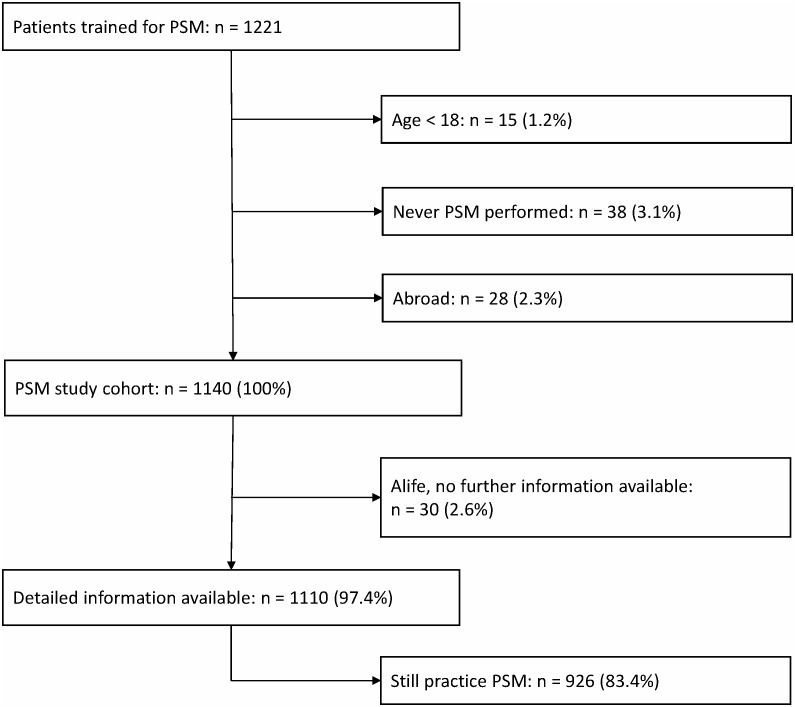
PSM study cohort.